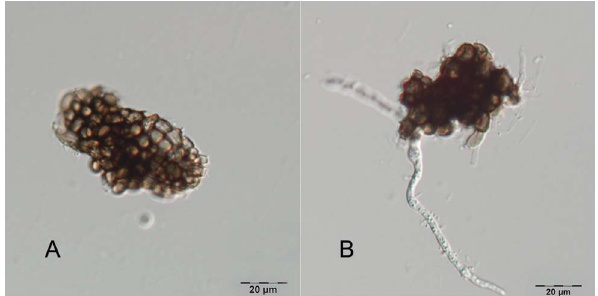
Figure 1. A non-germinated (A) and germinated (B) micro- sclerotia of Verticilliumdahliae